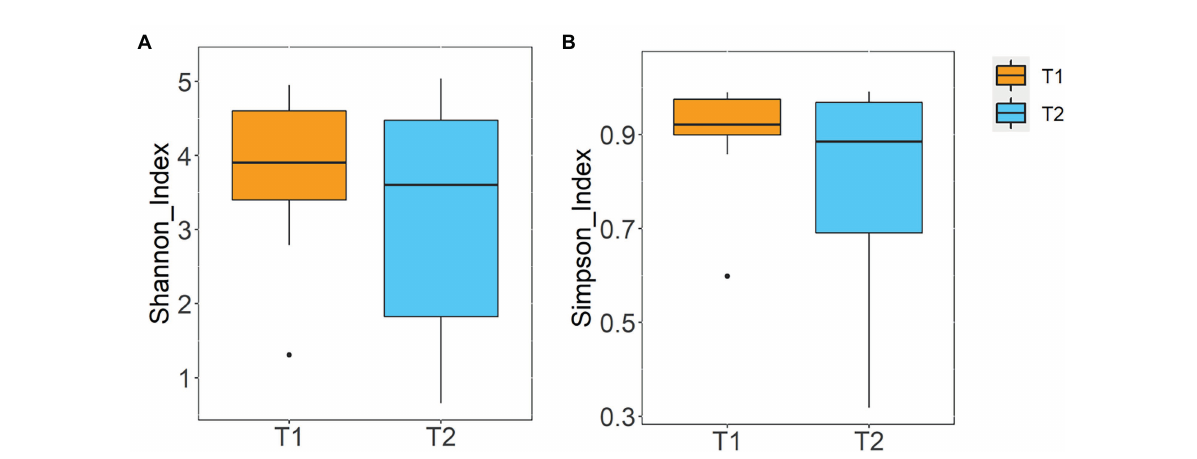
FIGURE 1 Alpha diversity at the ASV level of the nasal samples obtained at day 0 (T1) and at day 120 (T2). (A) Shannon diversity index; (B) Simpson diversity